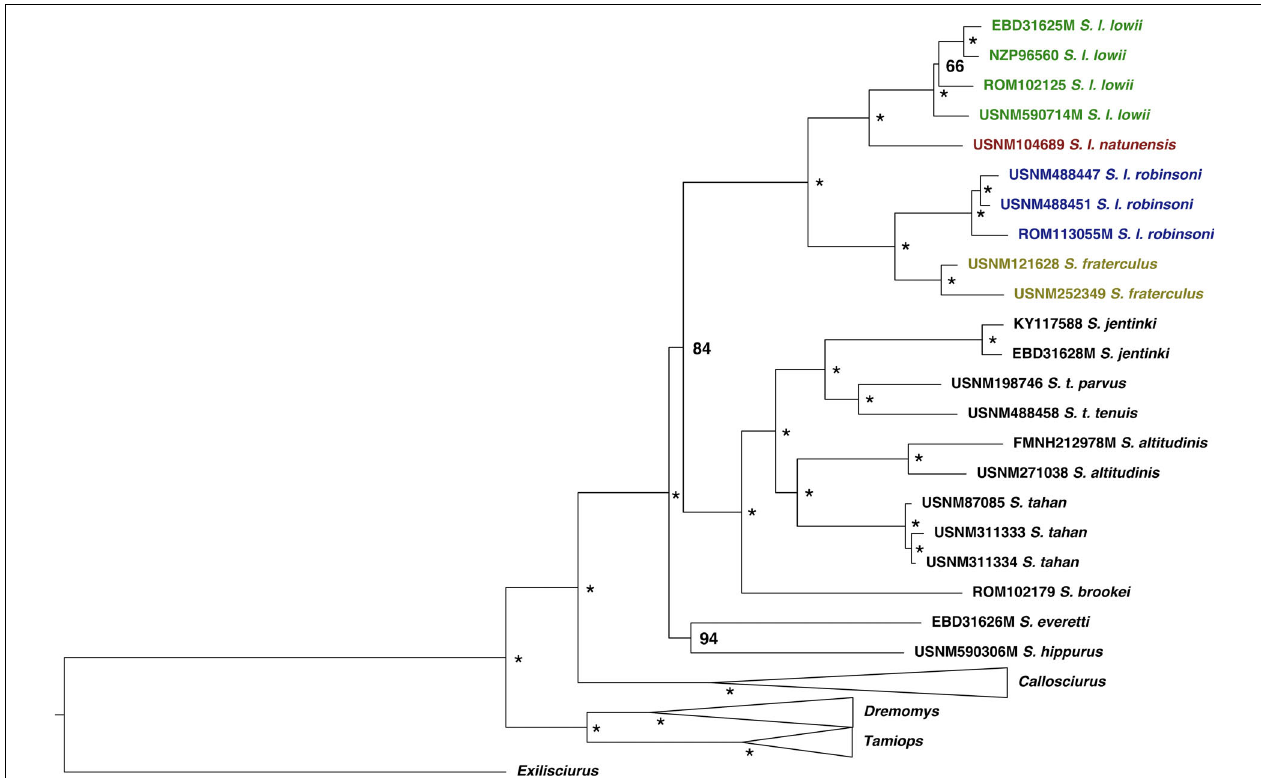
FIGURE 2 | Mitogenome-based maximum likelihood phylogeny for Sunda squirrels. Highly supported nodes (PP > 0.95) are shown with an asterisk. Posterior probabilities are specified in less supported nodes. Ingroup samples of the four main clades are colored to match map in Figure 1 . Outgroup samples are shown in black. Outgroup genera clades are collapsed for